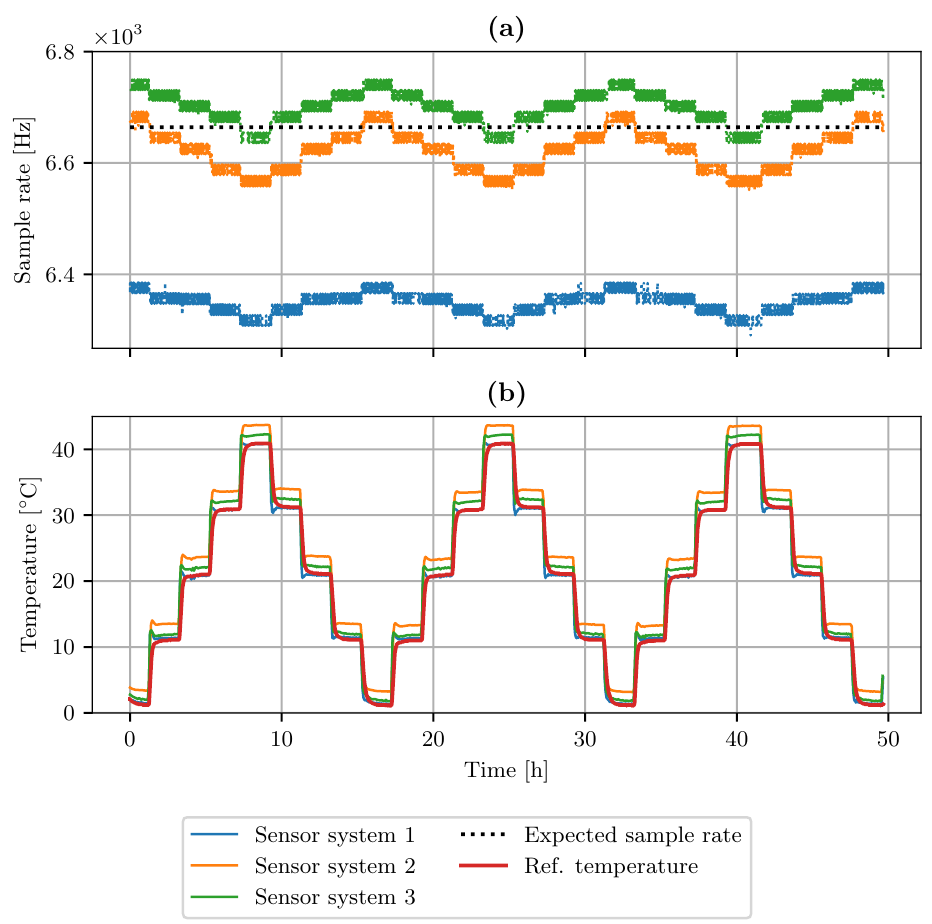
Figure 9. ( a ) Measured and expected sample rate of three LSM6DSL sensor systems. ( b ) Temperature profile of VT 7010 as measured by BMP280 temperature